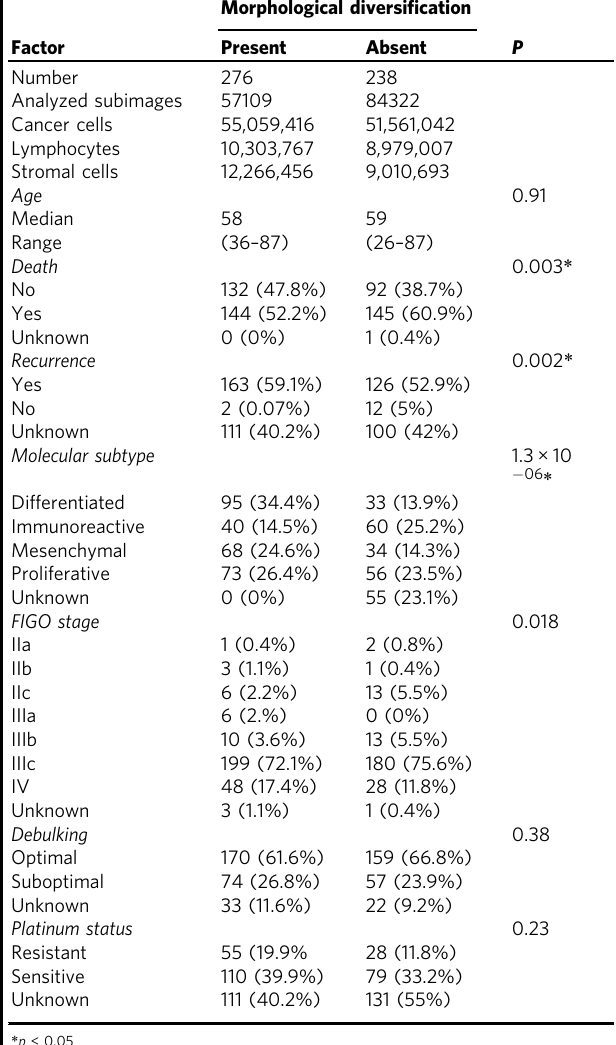
Table 3 Patient clinicopathologic characteristics strati fi ed by presence/absence of morphological diversi fi